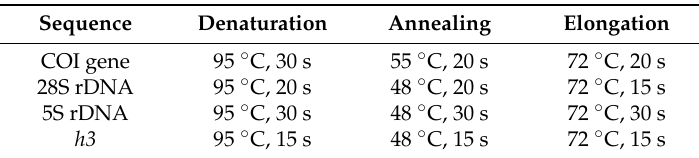
Table 1. Parameters used in the